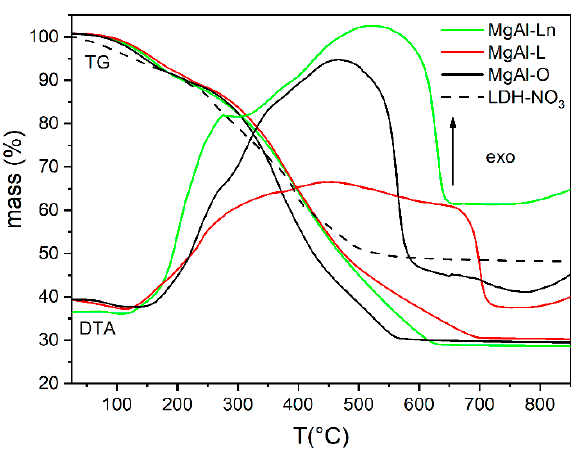
Figure 2. TGA and DTA curves of the indicated samples prepared in H 2 O/EtOH as a solvent com- pared with LDH-NO 3 . Operative conditions: air, 10 °C/min.